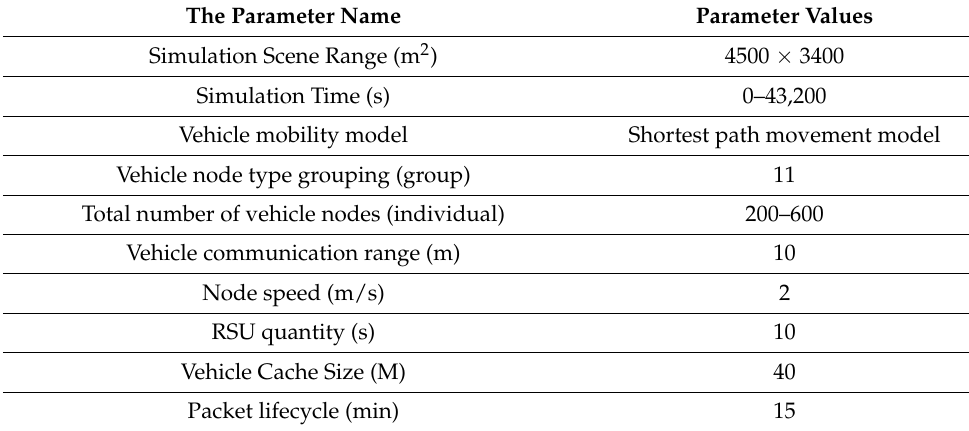
Table 2. Experimental simulation parameters are set.